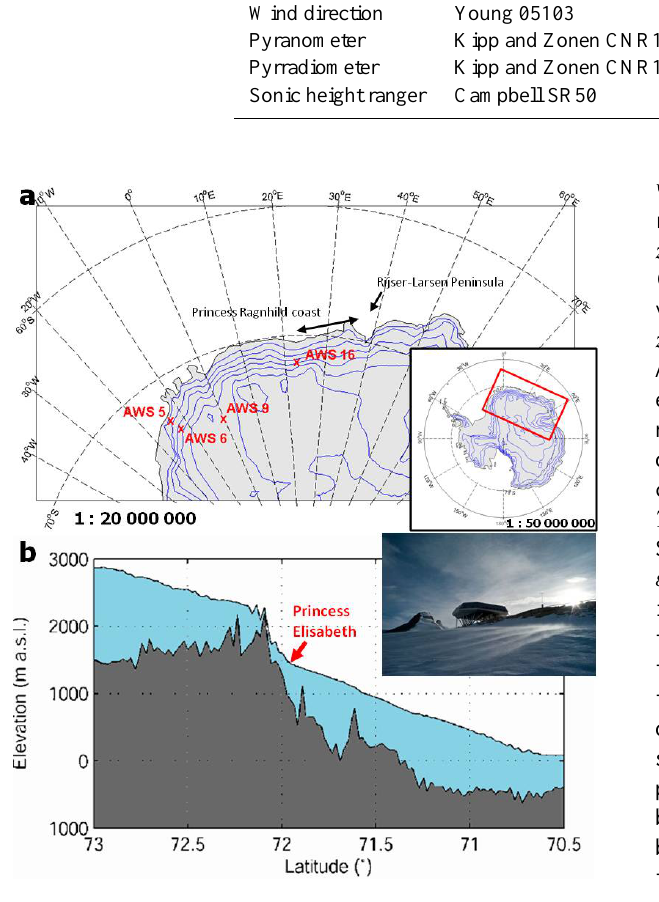
Fig. 1. (a) Map with focus on Dronning Maud Land, indicating the location of the 4 automatic weather stations (AWSs) under con- sideration. 500m height contours are depicted in blue (http://www. eos.ubc.ca/ ∼ rich/map.html). (b) Surface (Bamber et al., 2009) and bedrock (Lythe and Vaughan, 2001) topographic transect along the 23 ◦ E meridian (adapted from Pattyn et al., 2009). The outcropping bedrock at ∼ 72.1 ◦ S form the Sør Rondane mountains. Inset: snow- drift event at Princess Elisabeth, where AWS 16 is